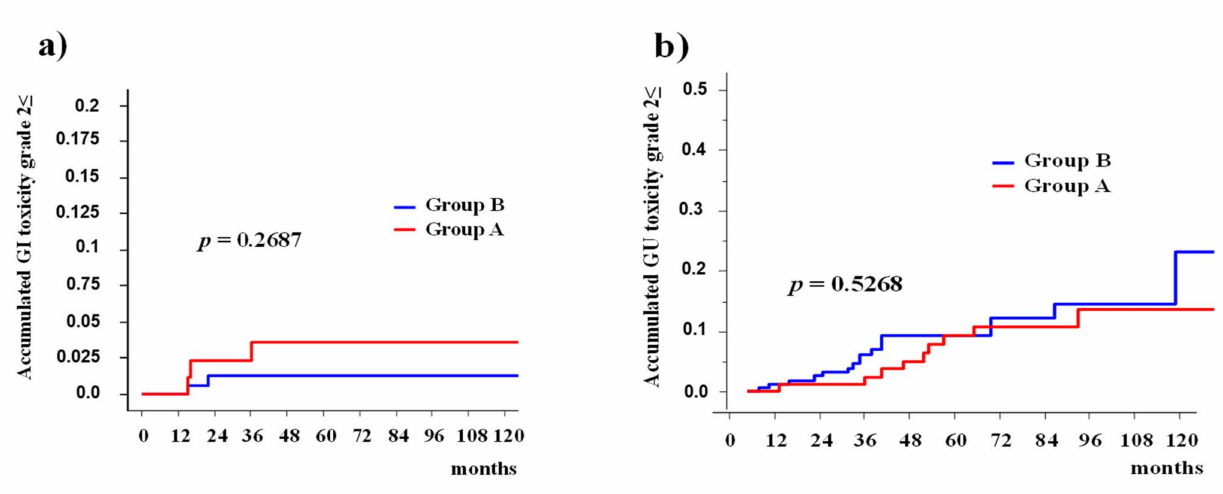
Figure 4. Accumulated incidence of grade ≥ 2 late toxicity between Group A and B. ( a ) Accumulated incidence of grade ≥ 2 gastrointestinal (GI). ( b ) Accumulated incidence of grade ≥ 2 genitourinary (GU)